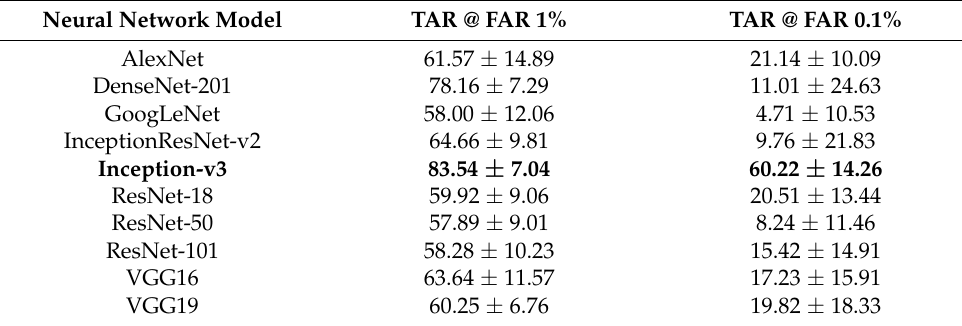
Table 6. TAR results for the VTI